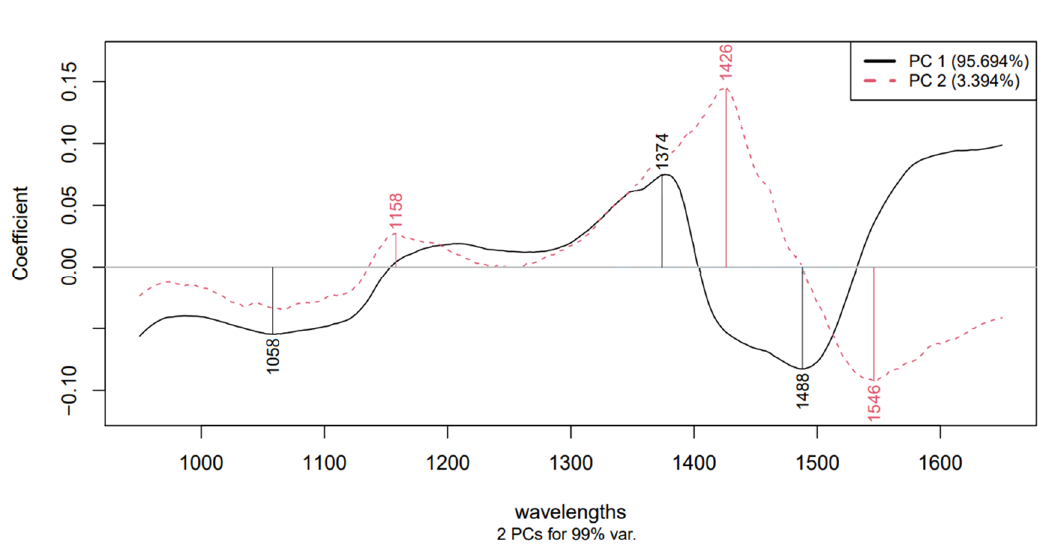
Figure 6. Loading plot of liquid egg treated at 20 kHz and 3.7 W. Table 2. The contributing wavelengths for principal component analysis (PCA) based on loading values. Egg Product